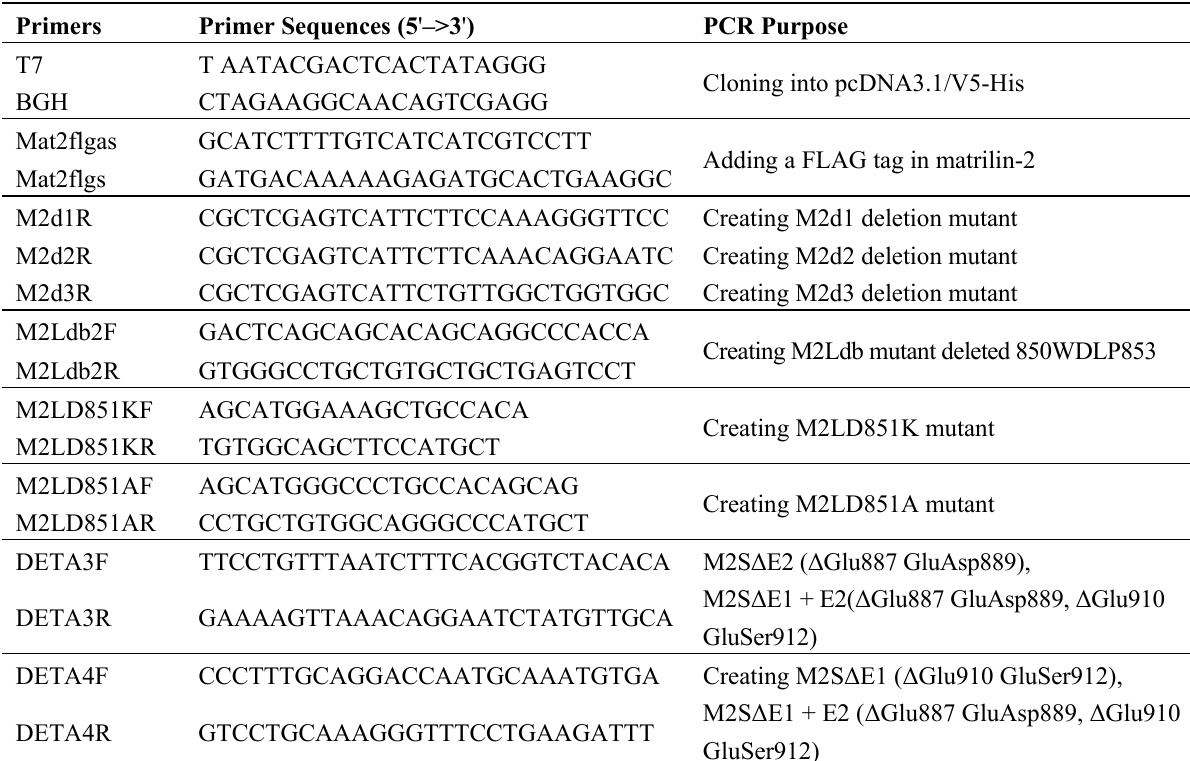
Table 1. A list of primers for generating matrilin-2 cDNA